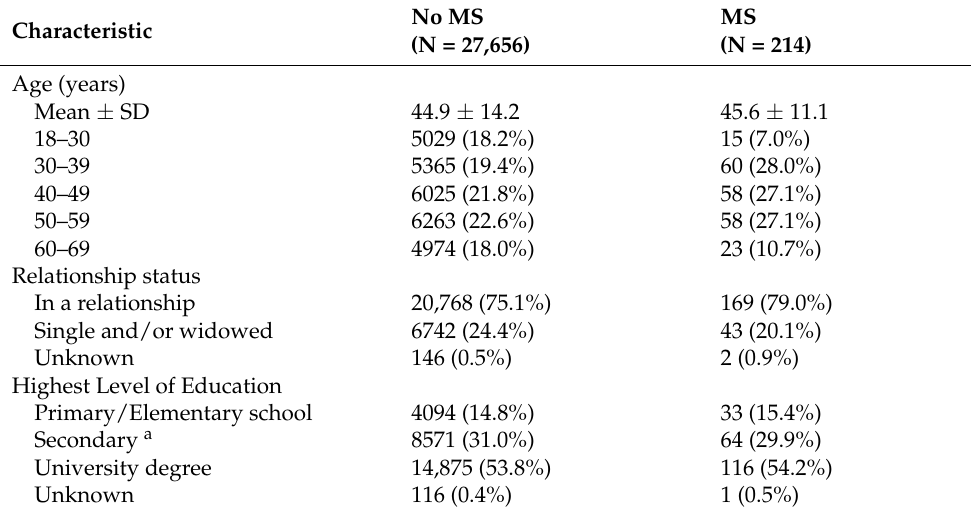
Table 1. Characteristics of women with and without prevalent multiple sclerosis (MS) in the SAGA Cohort, number (%) or mean ± standard